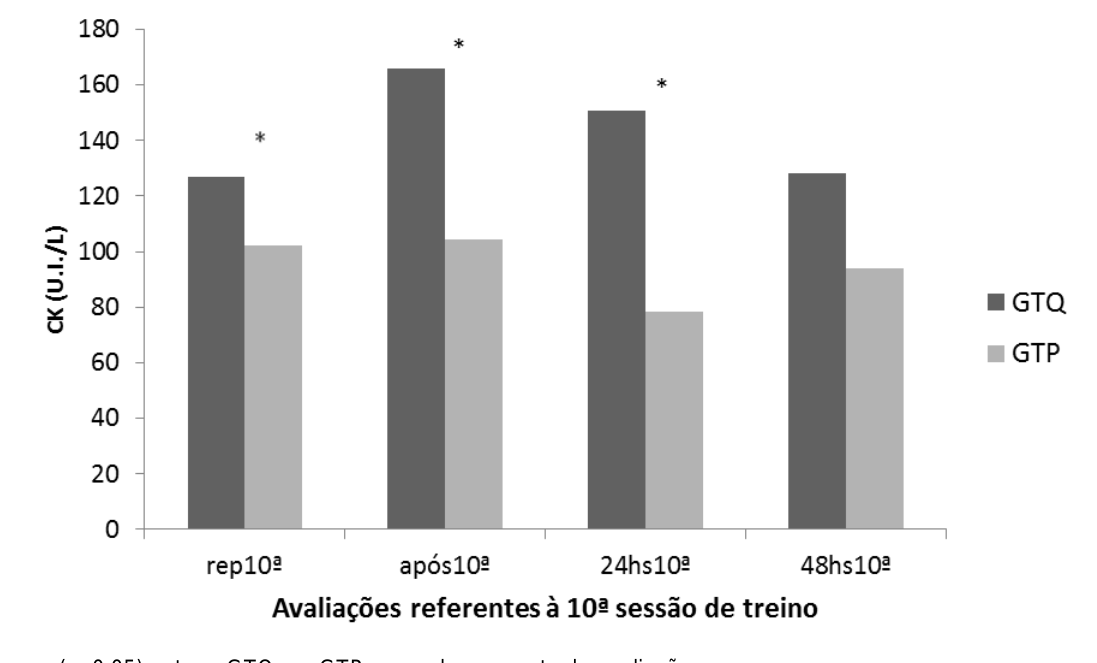
Figura 1. Comparação entre o grupo submetido ao treino em quadra (GTQ) e o grupo submetido ao treino na piscina (GTP) com relação aos níveis da creatina quinase (CK) durante as avaliações realizadas na 10ª sessão de